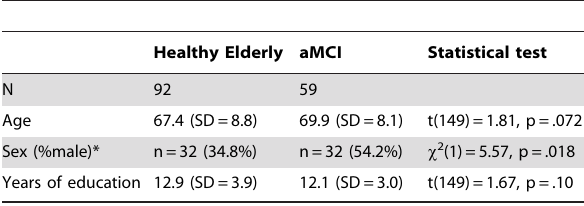
Table 1. Demographic characteristics of healthy elderly and aMCI groups.